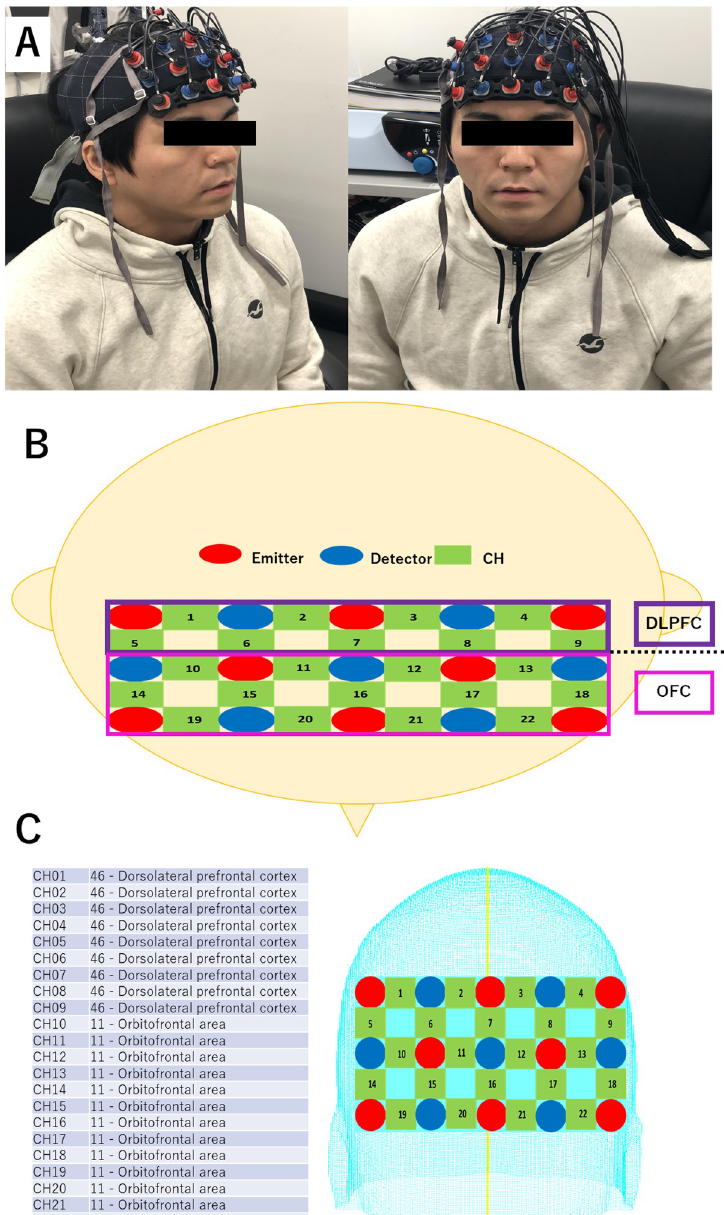
Fig 2. NIRS measurement. A . A typical picture of a participant equipped with NIRS optodes. B . The NIRS comprised 8 elements for the NIR light emitter (red) and 7 elements for the detector (blue). The numbers indicate the channels (green) recorded. The NIRS channels were placed above the dorsolateral prefrontal cortex (DLPFC) and the orbitofrontal cortex (OFC). C . The channels between the optodes measured on the skull were assigned to the brain regions using the virtual registration